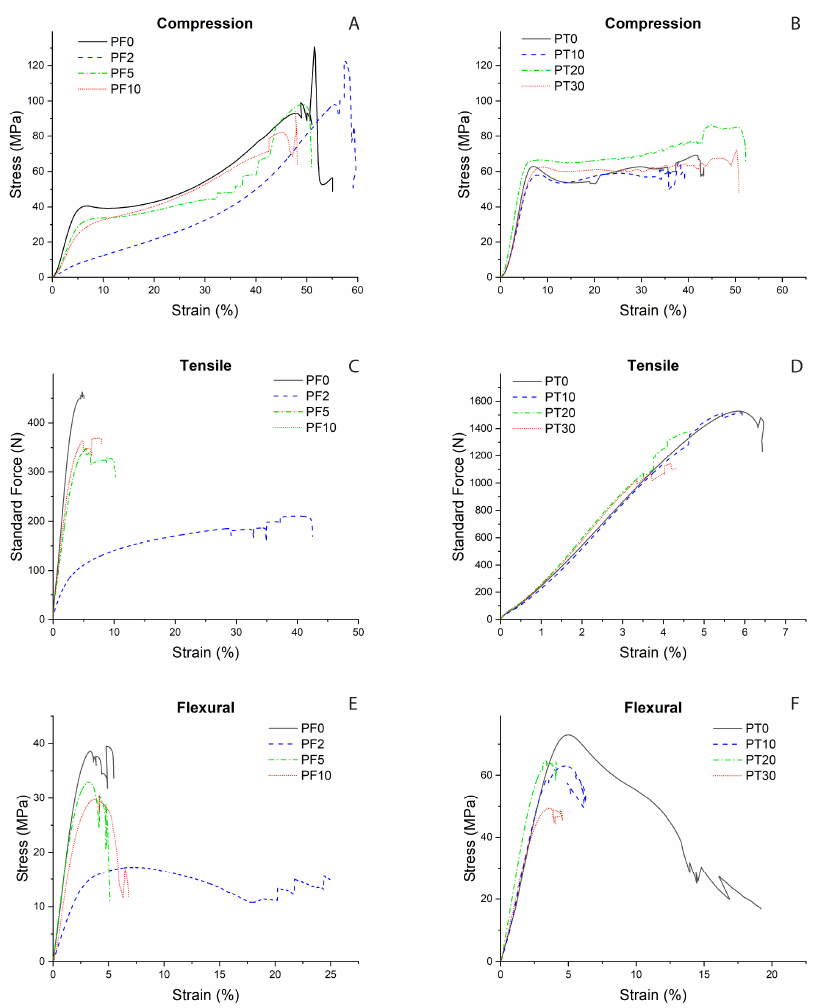
Figure 2. Effects of the DCAP filler amount on the compressive strength ( A , B ), tensile strengths ( C , D ), and flexural strengths ( E , F ) for the PF ( A , C , E ) and PT ( B , D , F ) composite samples.